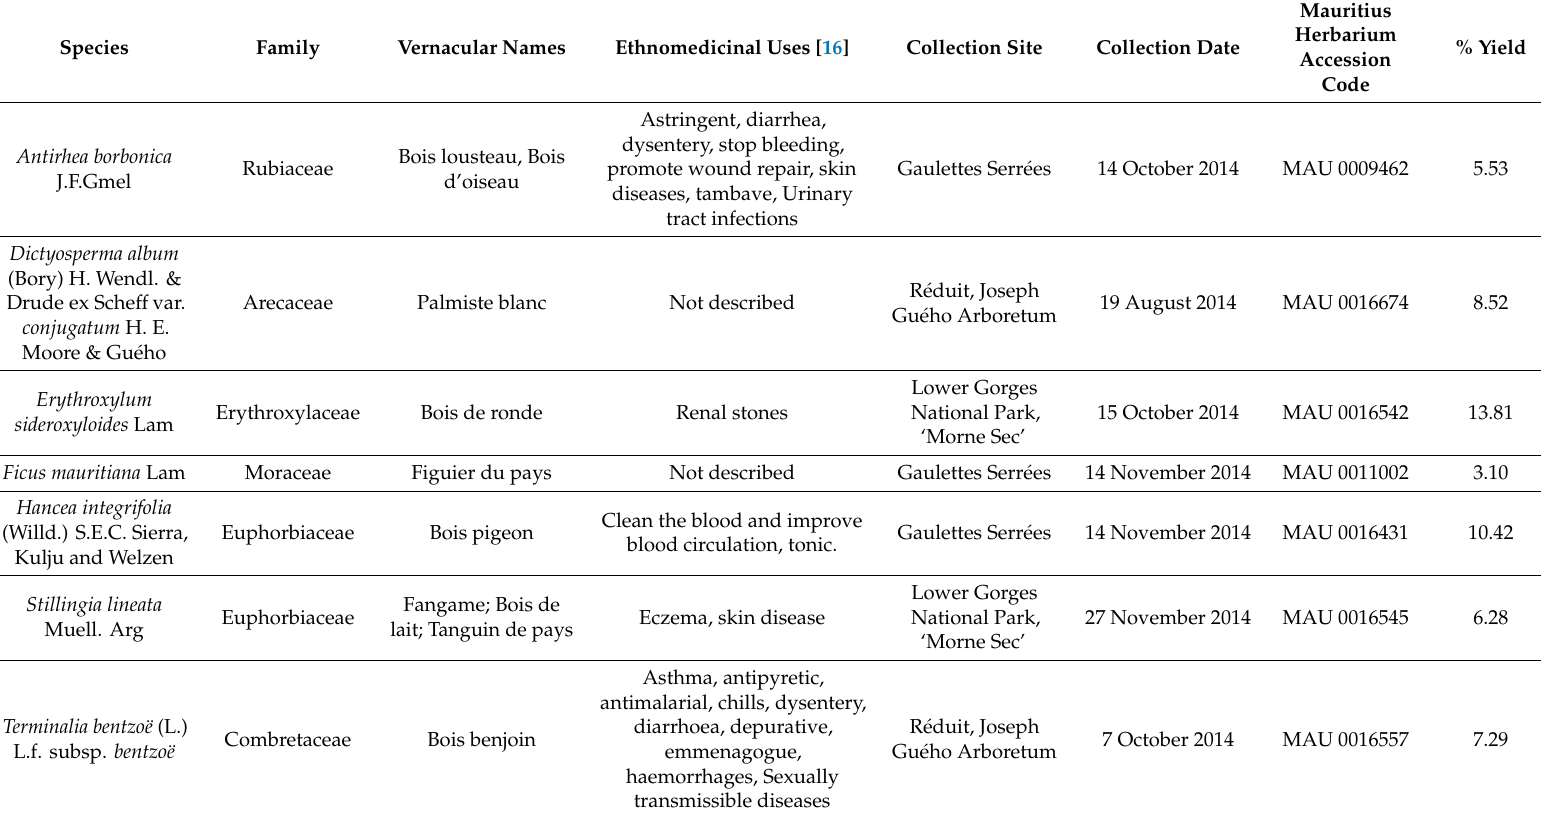
Table 1. The investigated Mascarene endemic plant